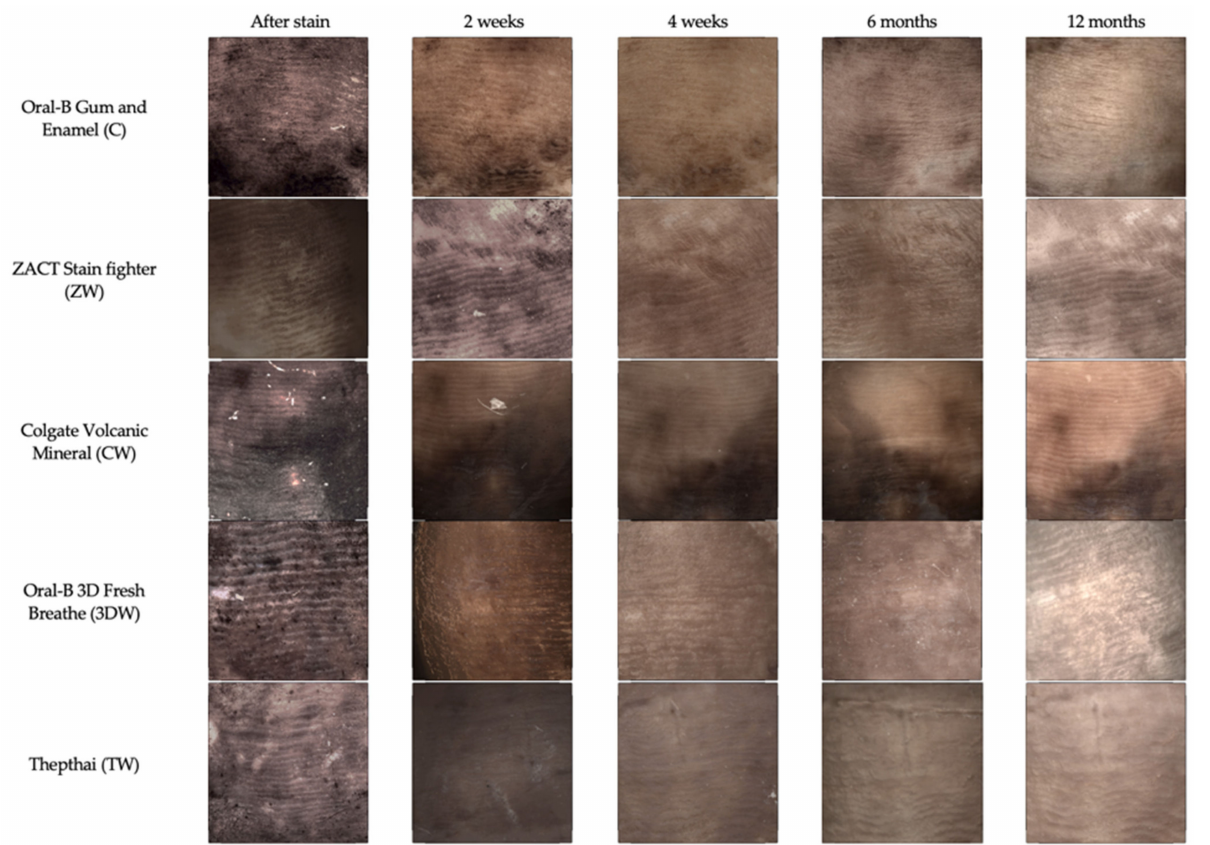
Figure 3. Colour of stained enamel surface of each group after brushing with different toothpastes over time. Table 4. Mean and standard deviation of ∆ L (difference between baseline and period of time) after brushing. In the same column, different superscript lowercase letters indicate statistically significant differences among different toothpaste groups. In the same line, different superscript capital letters indicate statistically significant differences only among the evaluation periods in the same groups ( p <